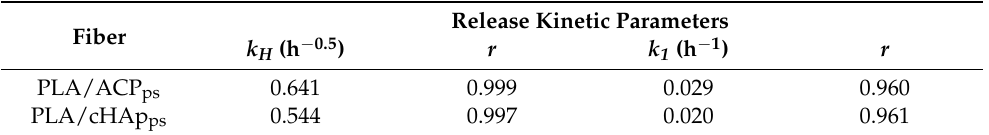
Figure 13. Contact angles ( a ) and STR release curves in a PBS medium ( b ) determined for different PLA electrospun matrices. Table 4. Release kinetic parameters in a PBS medium for PLA electrospun samples incorporating ACP ps and cHAp ps nanoparticles.